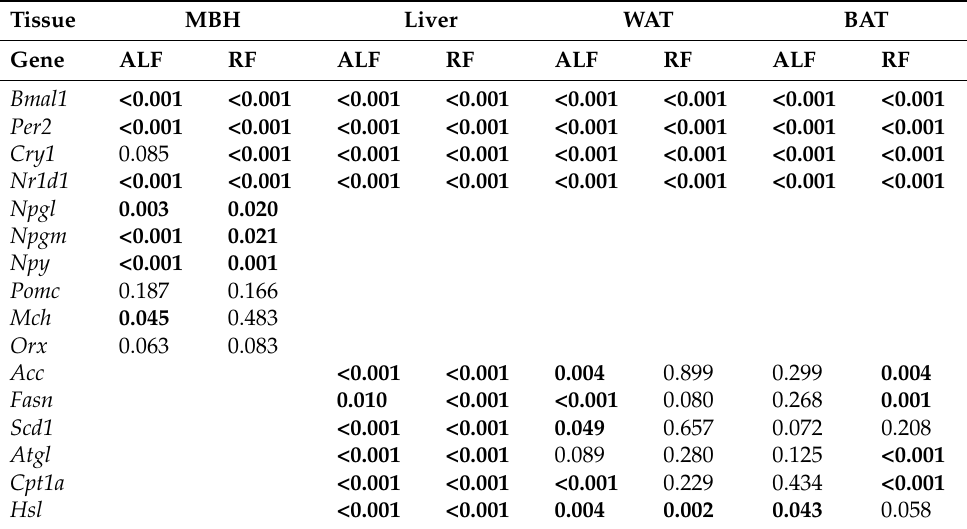
Table 1. Results of one-way ANOVA analyses on mRNA expression. Bold font indicates statisti- cal significance.